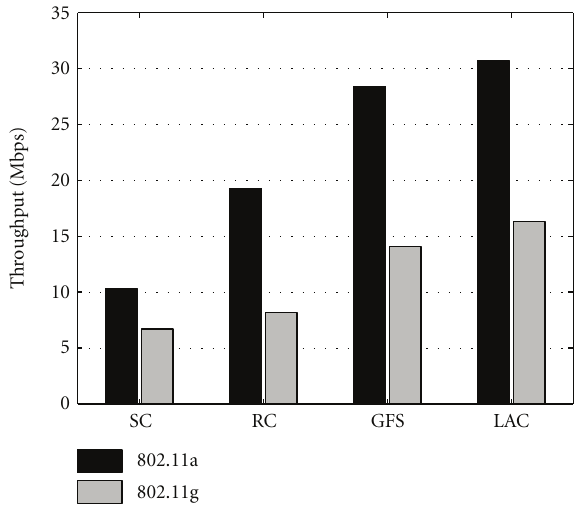
Figure 1: Total network throughput with saturated downlink UDP tra ffi